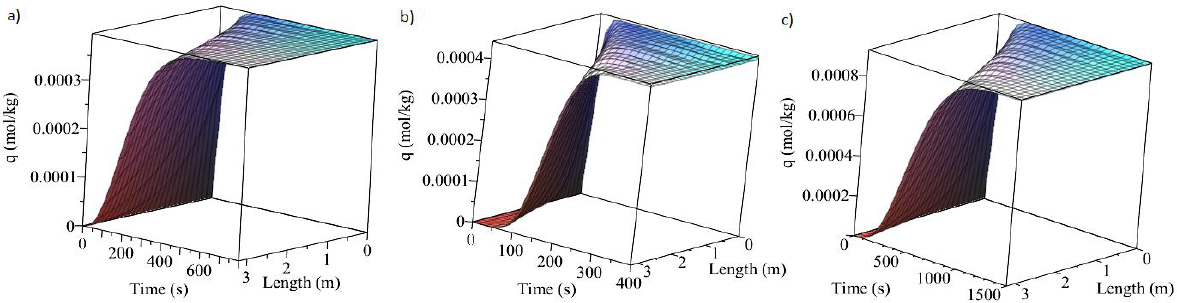
Figure 4. Breakthrough curves (CO 2 concentration at the outlet/CO 2 concentration at the inlet) for chemisorbents.